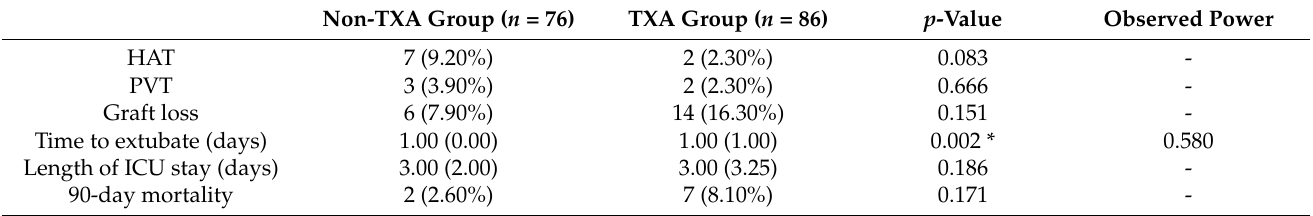
Table 3. Postoperative outcomes of LT patients categorised by intraoperative treatment of TXA. Non-TXA Group ( n = 76) TXA Group ( n = 86) p -Value Observed